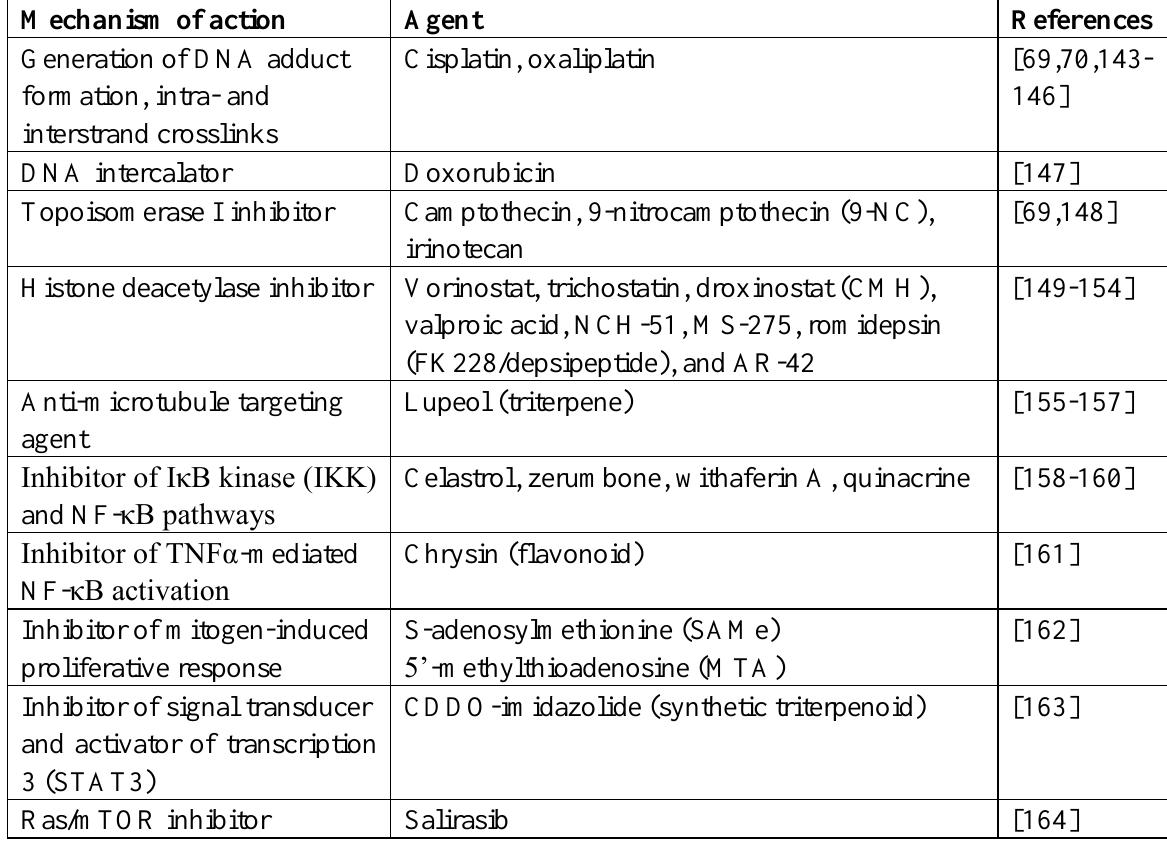
Table 1. Agents known to inhibit c-FLIP expression at the transcription level.